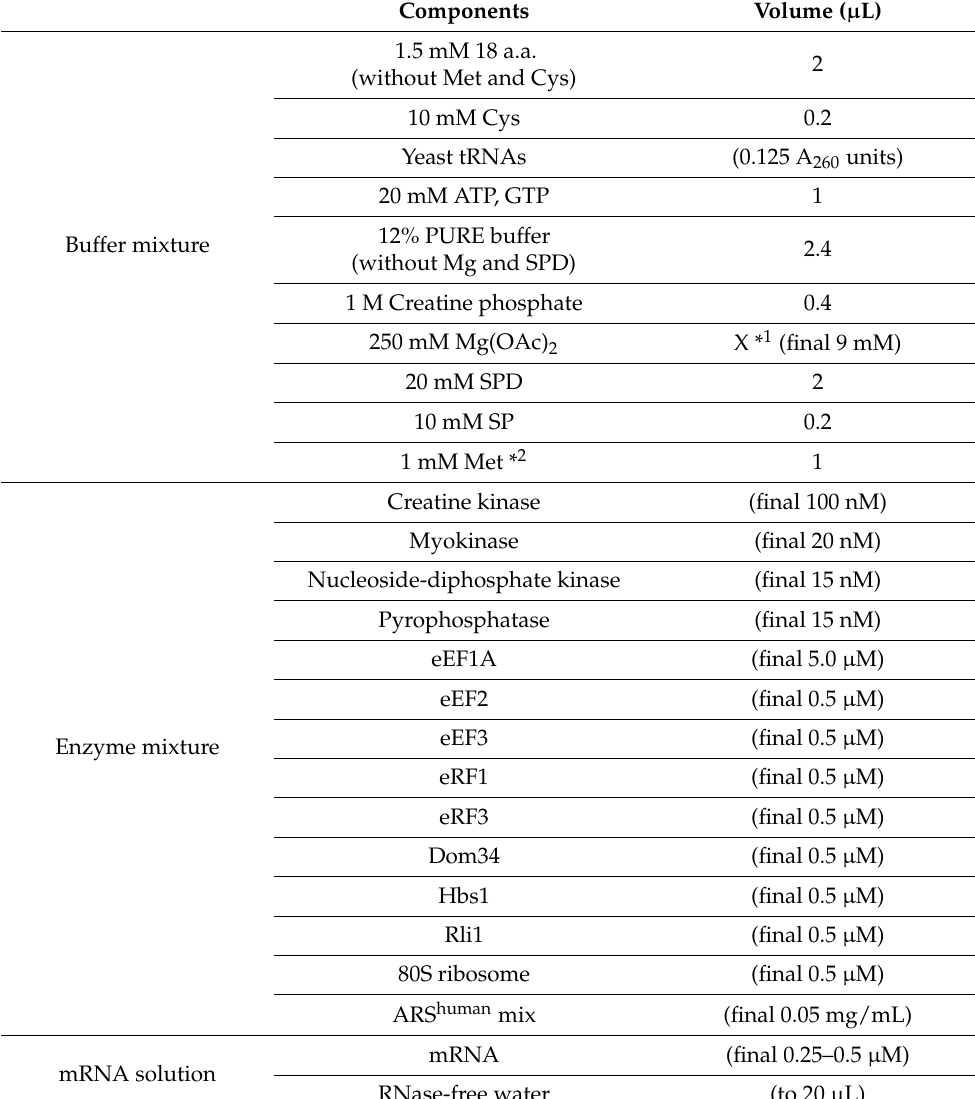
Table 3. Components in the “Aminoacylation-Translation Coupled